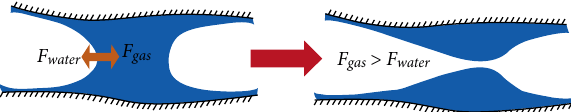
Figure 1: Gas transport mechanism in pores of CBM reservoirs containing water.